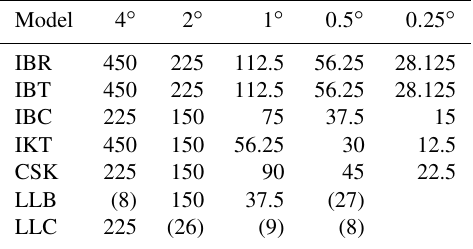
Table 4. For each model and approximate horizontal resolution, the largest dynamical time step, half of leap-frog time step, in seconds for which the model survives for 50 days without major instabilities, or after what day the model diverged (in parentheses), for solid body rotation initial conditions with Earth’s bottom topography.